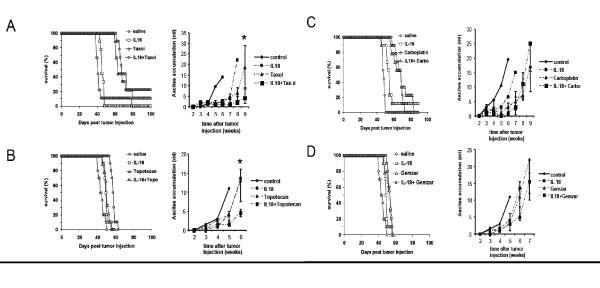
IL-18 improves only the antitumor effect of time-dependent drugs. (A) Combination therapy with IL-18 improves the survival benefit offered by paclitaxel and topotecan alone and restricts ascites accumulation (left). C57BL/6 mice were injected i.p. with 5 × 106 ID8-Vegf cells on day 0 and subsequently treated with the indicated types of treatment. Mice treated with the combination of paclitaxel plus IL-18 had a significantly prolonged survival compared to the respective monotherapies (p < 0.01; control n = 23, IL-18 alone n = 22, paclitaxel n = 14, IL-18 plus paclitaxel n = 13). Combination therapy significantly restricted ascites accumulation (right) compared to the respective monotherapies as measured by the increase in the animal weight. The asterisks show data points where the difference in ascites accumulation is significant (Student's test, P < 0.001). (B) The combination of topotecan plus IL-18 also significantly prolonged the survival comparing to the respective monotherapies (p < 0.01; control n = 10, IL-18 alone n = 10, topotecan alone n = 9, IL-18 plus paclitaxel n = 10). Combination therapy significantly restricted ascites accumulation (right). The addition of IL-18 to carboplatin (C) or gemcitabine (D) did not significantly improve survival (left) or restrict ascites accumulation (right). IL-18/carboplatin experiment: Control n = 9, IL-18 n = 9, carboplatin n = 9, IL-18 plus carboplatin n = 9. IL-18/gemcitabine experiment: Control n = 10, IL-18 n = 10, gemcitabine n = 9, IL-18 plus gemcitabine n = 10.